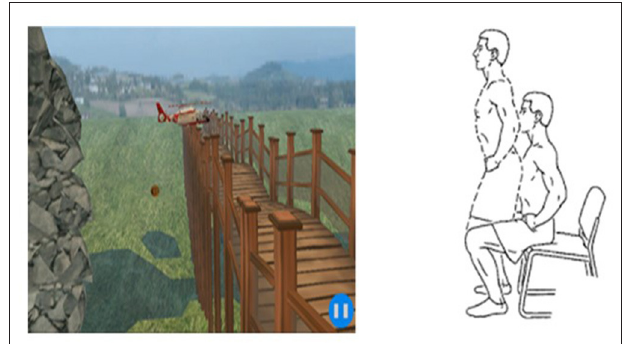
FIGURE 1 | Sit to stand game through virtual